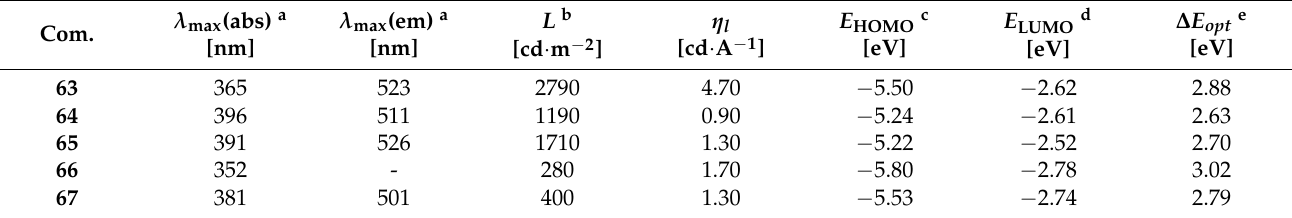
Figure 5. A library of structurally varied fluorophores, based on thieno[3,2- b ]thiophene. Table 4. The optoelectronic properties of TTs 63 – 67 applied in OLEDs.